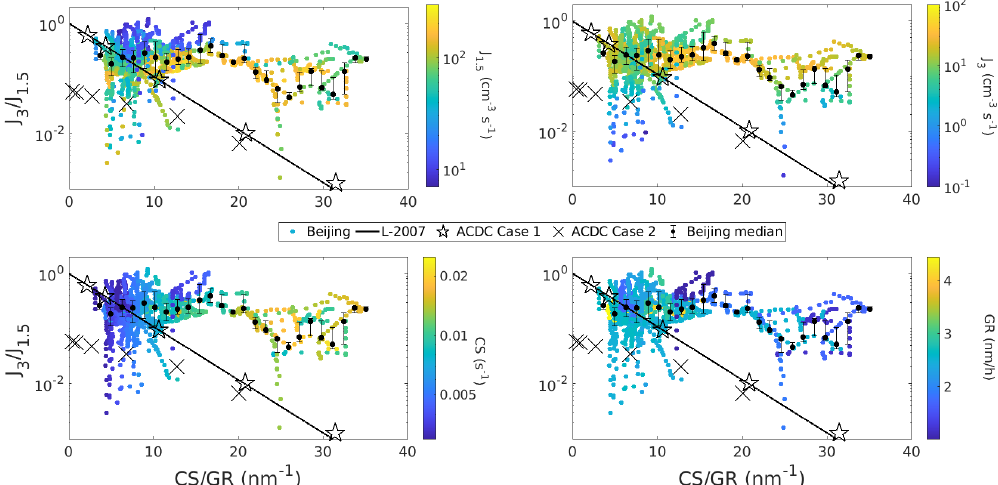
Figure 7. Survival probability from 1.5 to 3nm ( J 3 /J 1 . 5 ) as a function of the ratio of the condensation sink and the growth rate (CS / GR). Survival probabilities from Beijing, China, the ACDC model simulations, and the predictions based on the theoretical formulation by Lehti- nen et al. (2007) (L-2007) are included. ACDC Case 1 refers to simulations with no collisions between the clusters, while in Case 2 simula- tions, cluster–cluster collisions also occurred. The median values for the observed J 3 /J 1 . 5 have been determined based on a bin division of horizontal values and the quartiles are shown as the error bars. The top left figure is shaded with the J 1 . 5 while the top right, the bottom left, and the bottom right are shaded with the J 3 , the CS, and the GR,